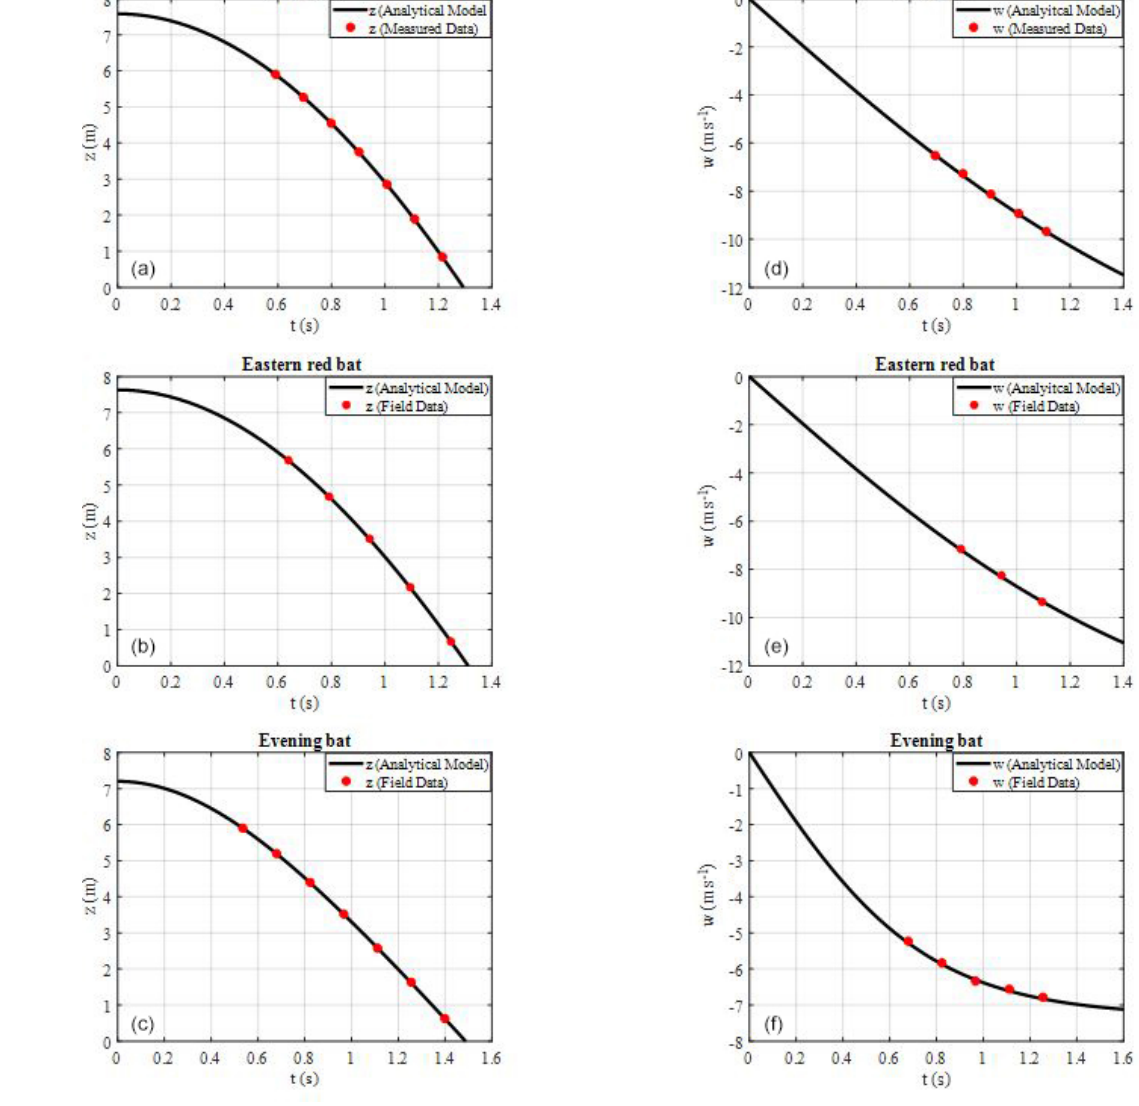
Figure 8. Comparison of position (a–c) and velocity (d–f) of the analytical solution and measured data for carcass drop tests of three bat